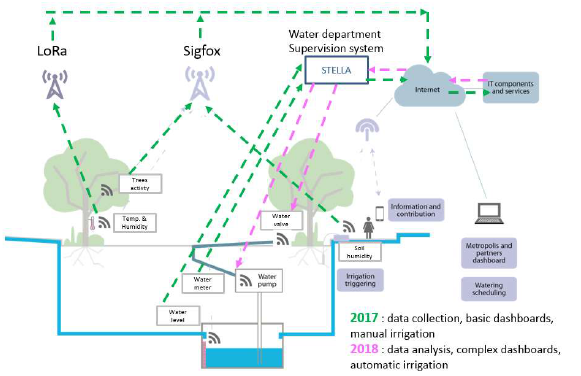
Figure 5. Garibaldi Street, overview of the sensor